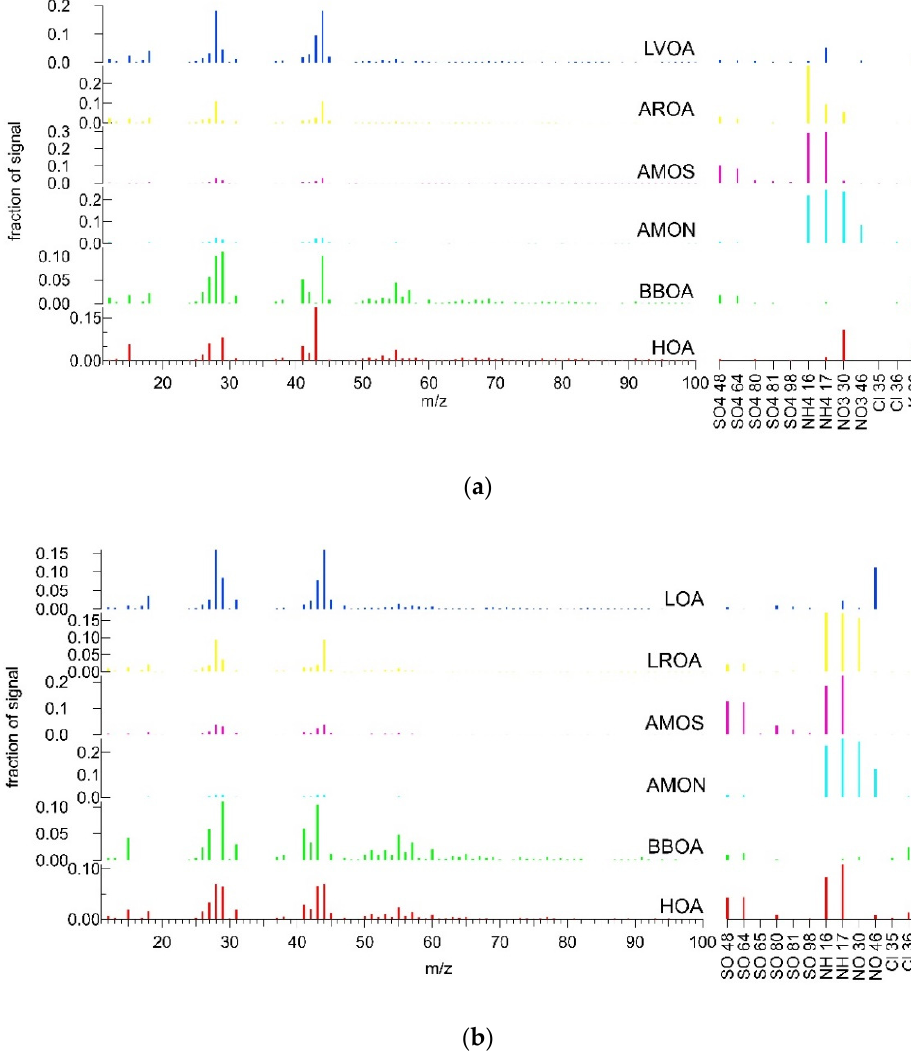
Figure 5. Factor profiles obtained by analysis of combined (organic + inorganic) mass spectra from ( a ) summer campaign and ( b ) winter campaign.